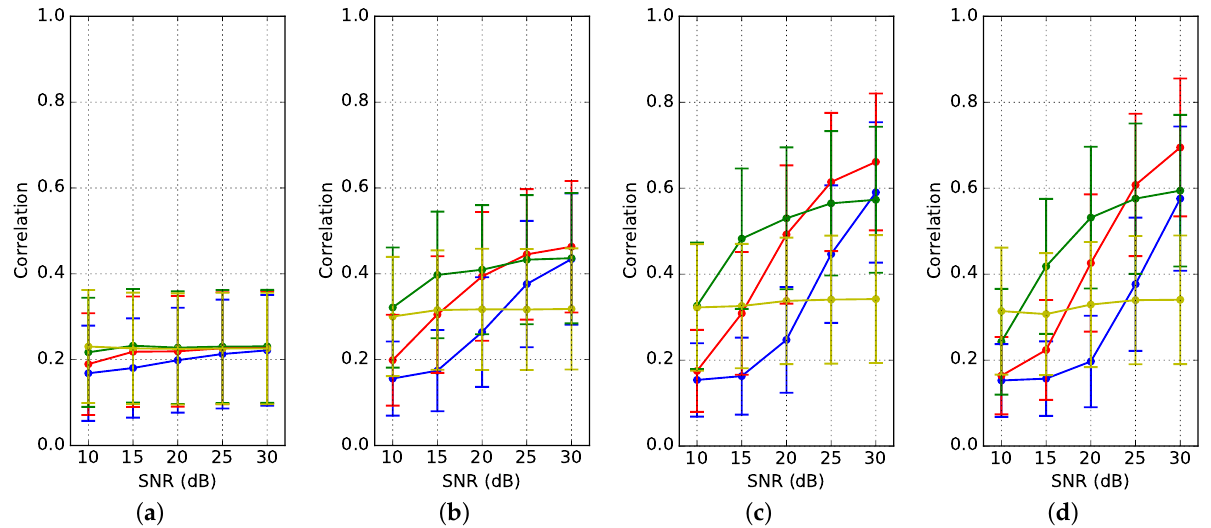
Figure 13. The mean (solid circle) and STD (fluctuating range) of the correlation amplitude between the original and compensated images against the SNR, and in dependence upon the looks number (blue lines: Q = 32 2 , red lines: Q = 64 2 , green lines: Q = 128 2 , yellow lines: Q = 256 2 ) and the sub-apertures number. ( a ) M = 4, ( b ) M = 8, ( c ) M = 16, ( d ) M =